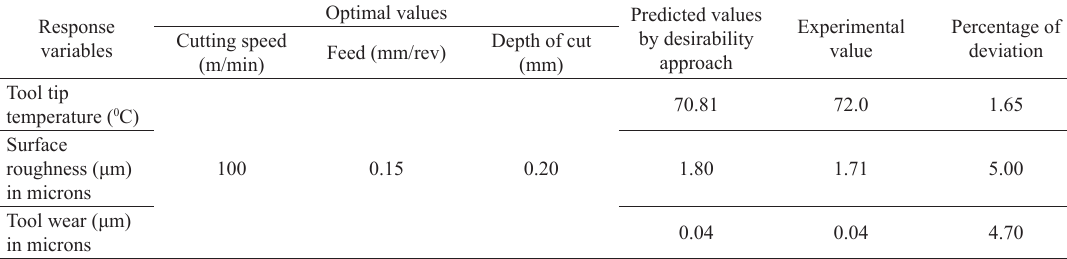
Table 11. Confirmation result. Response